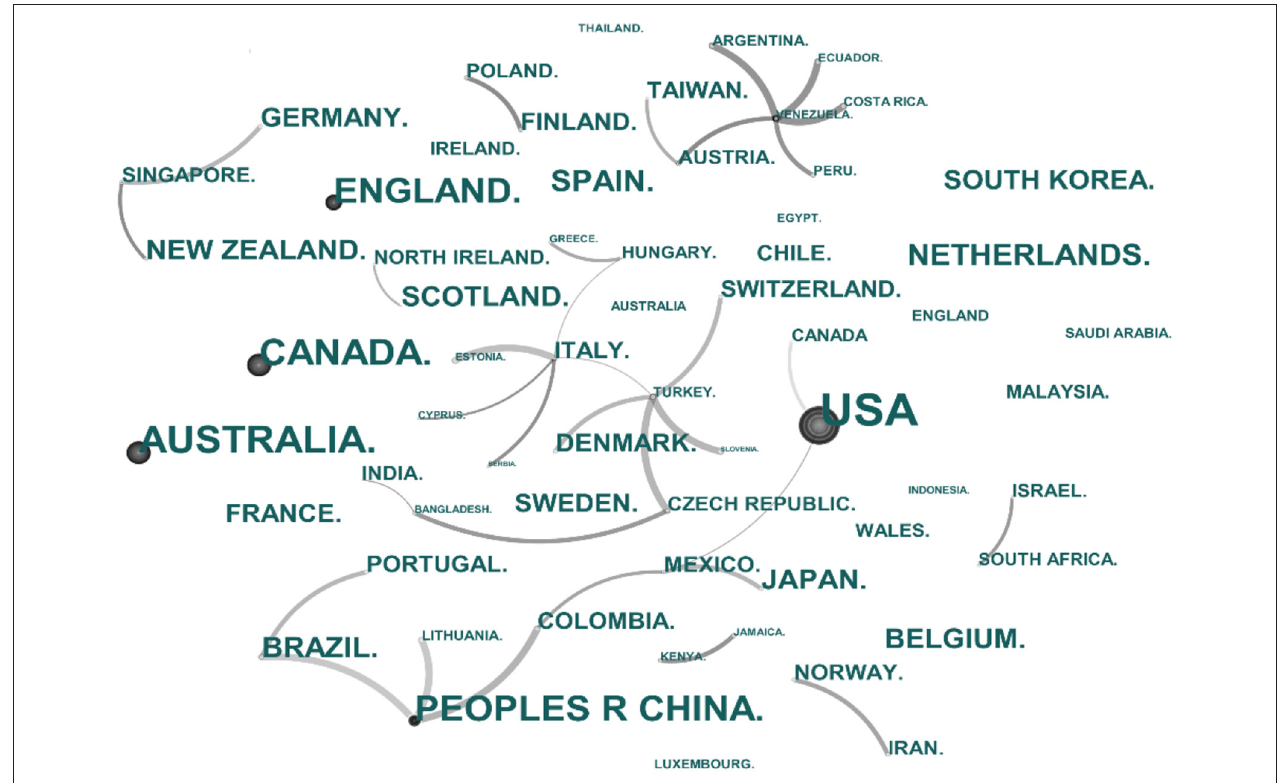
FIGURE 3 | Cluster diagram of study areas related to the built environments and health.